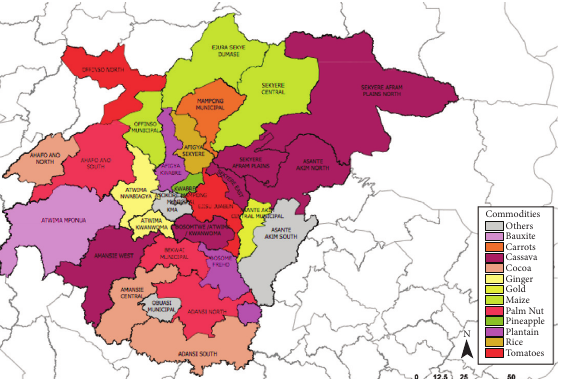
Figure 2: Map of the Ashanti Region indicating major commodities in the various districts (source: https://www.moti.gov.gh/1d1f/factories. php?region �